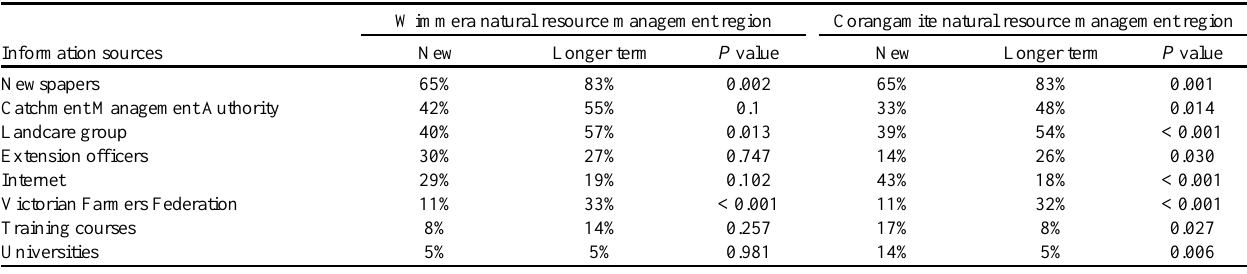
Table 6 . Comparing newer (Wimmera region: n = 68–79; Corangamite region: n = 82–85) and longer term (Wimmera region: n = 314–323; Corangamite region: n = 331–342) landholders: information sources. ( n denotes the number of respondents. Each item had a different number of respondents owing to missing values; these are indicated by the ranges in n